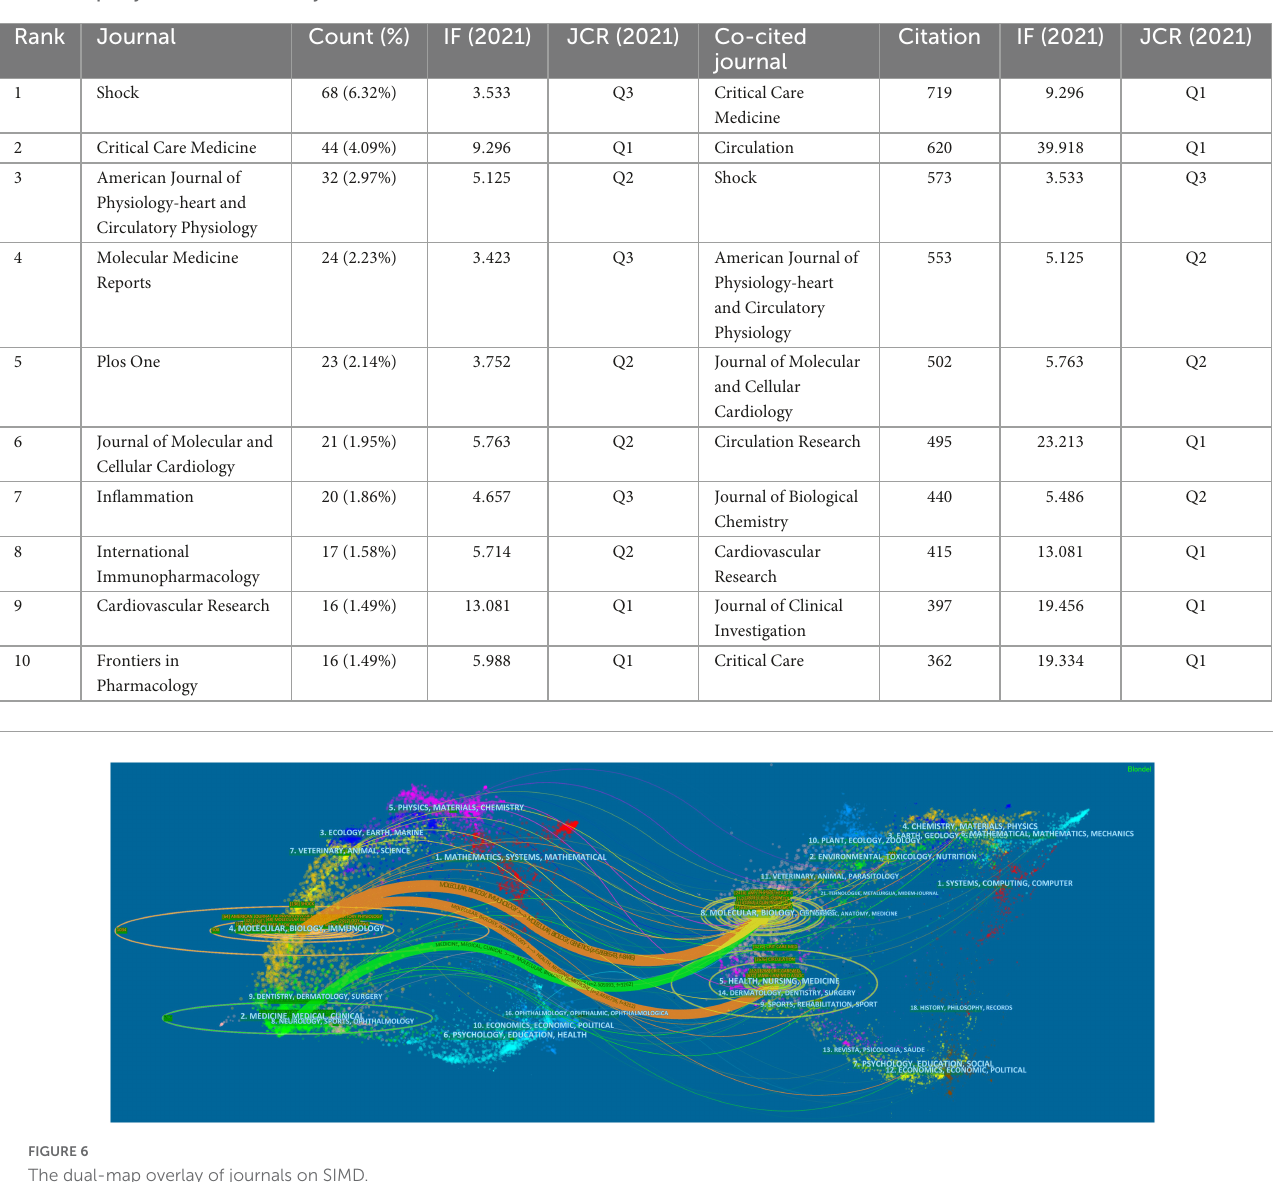
TABLE 3 Top 10 journals and co-cited journals related to SIMD.